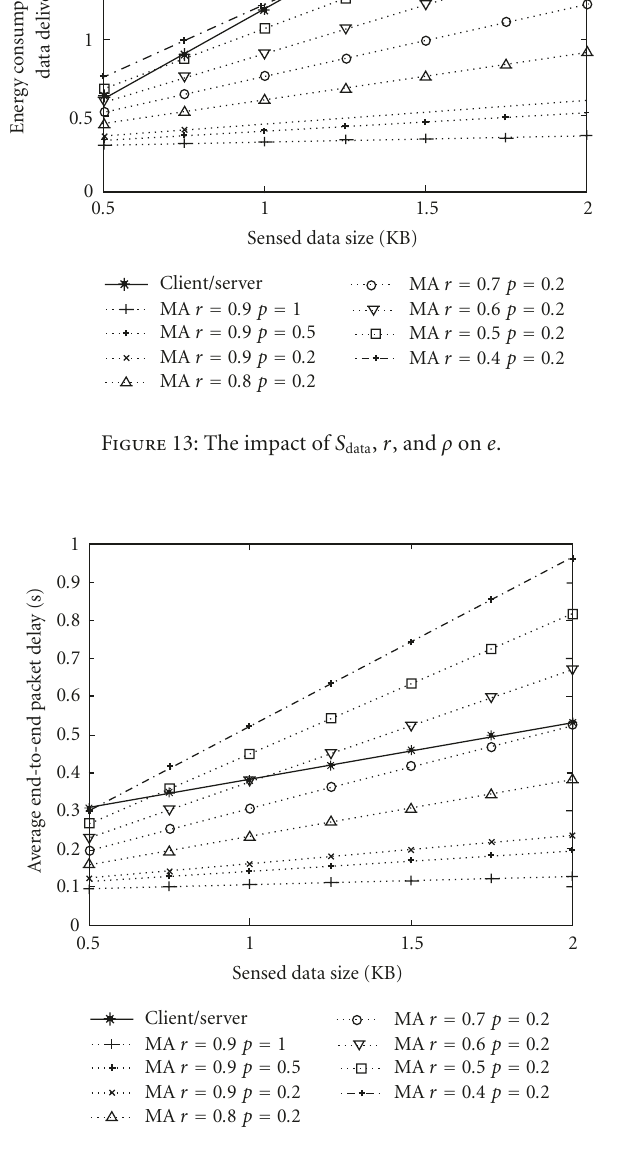
Figure 14: The impact of S data , r , and ρ on T ete .